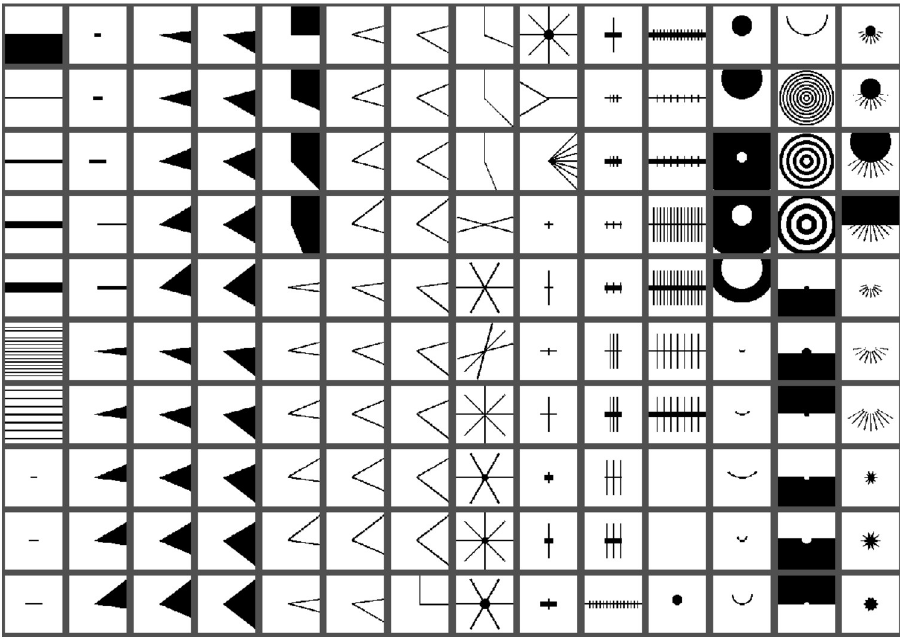
Fig 1. Image stimuli. The 138 prototype stimuli, including simple orientation patterns as well as complex ones, which generate all 9,500 stimuli used through rotation and translation.